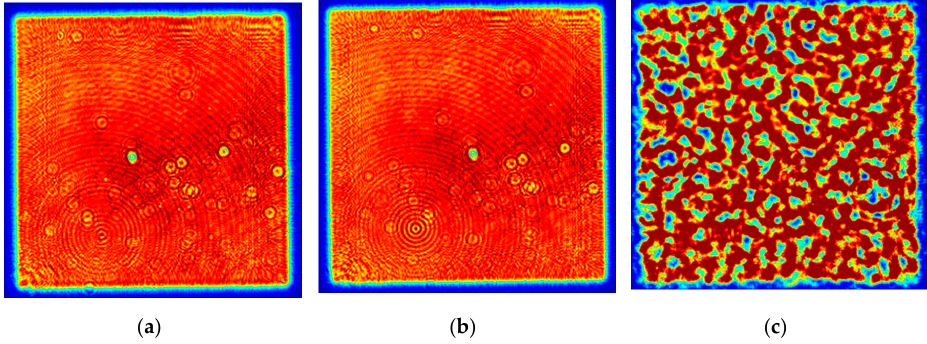
Figure 9. Material uniformity from CCD images: ( a ) no gain medium, ( b ) Nd:glass square rod and ( c ) NDSG rod.